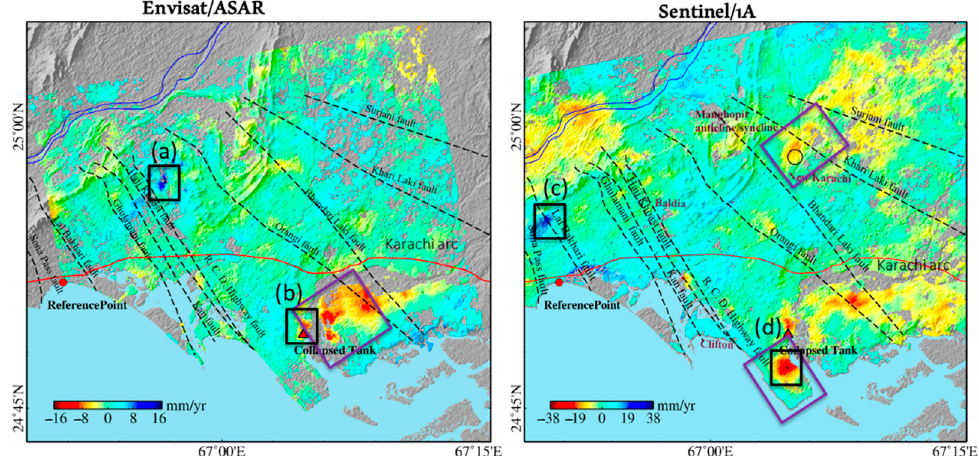
Figure 3. Vertical ground displacements in Karachi mapped through ENVISAT/SAR images over 2004–2010 ( left ) and Sentinel-1A images over 2014–2016 ( right ). Geologic features are overlaid, and major locations undergoing ground displacements are labeled (a–d) and highlighted. Positive values represent uplift, negative values represent ground subsidence.